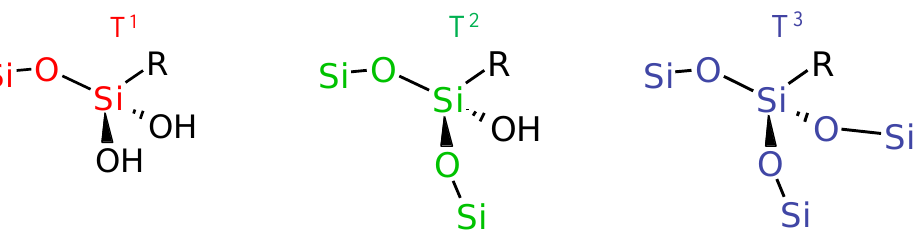
Figure 6. T species silicon atom types, exponent 1, 2 or 3 is related to the presence of one, two or three siloxane Si-O-Si bonds on the silicon atom of the organosilane.